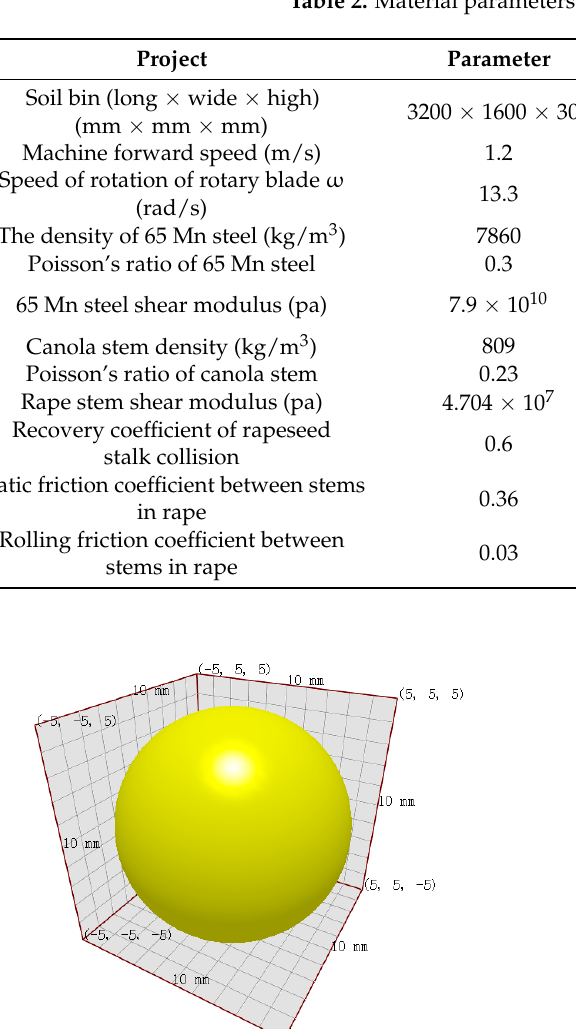
Table 2. Material parameters.